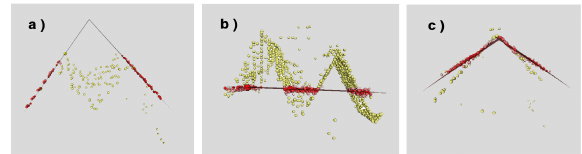
Figure 1. RANSAC: problems in estimating the roof model for observations (observations supporting the model are depicted red, the yellow ones do not support the model). a) expected models (gabled roofs) are contained in the model space of RANSAC. Since the model is supported only by a part of the observations, it delivers a false estimation. b) a false model (flat roof covering the whole observations) obtains more support than the smaller gabled roofs. c) large dormers mislead RANSAC to make a false estimation of a gable